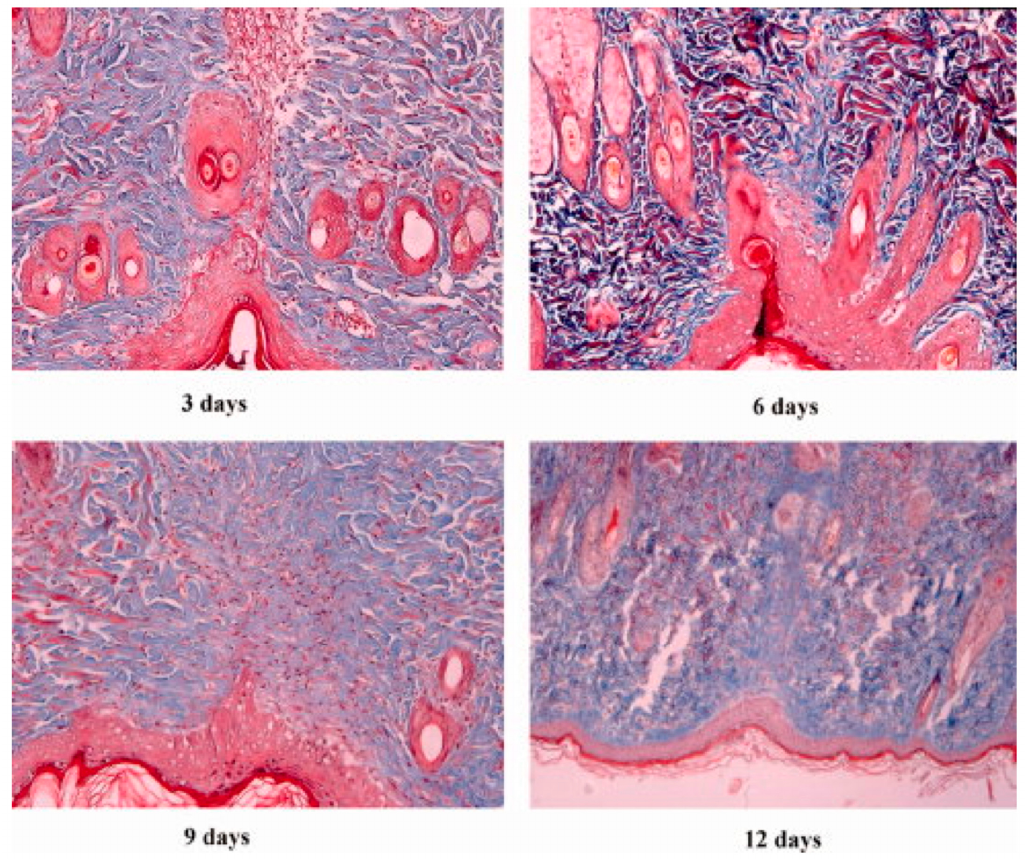
Figure 5. Cross section of porcine skin glued with HES-gelatin glue. It can be seen that by the end of 12th day the glue had completely disintegrated, and new connective tissue had developed. Reproduced with permission from [111].